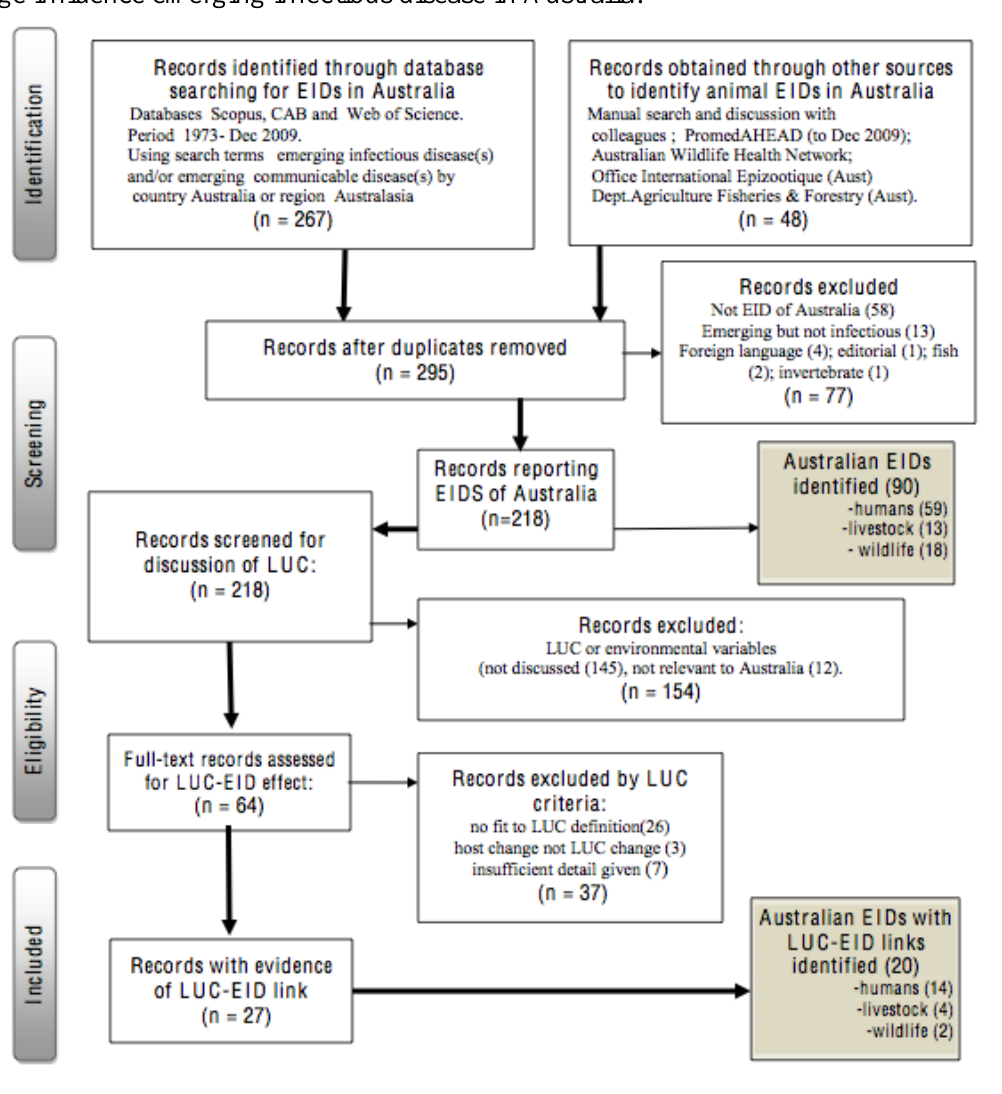
Figure 1. Data flow diagram showing systematic review process: does land-use and cover change influence emerging infectious disease in